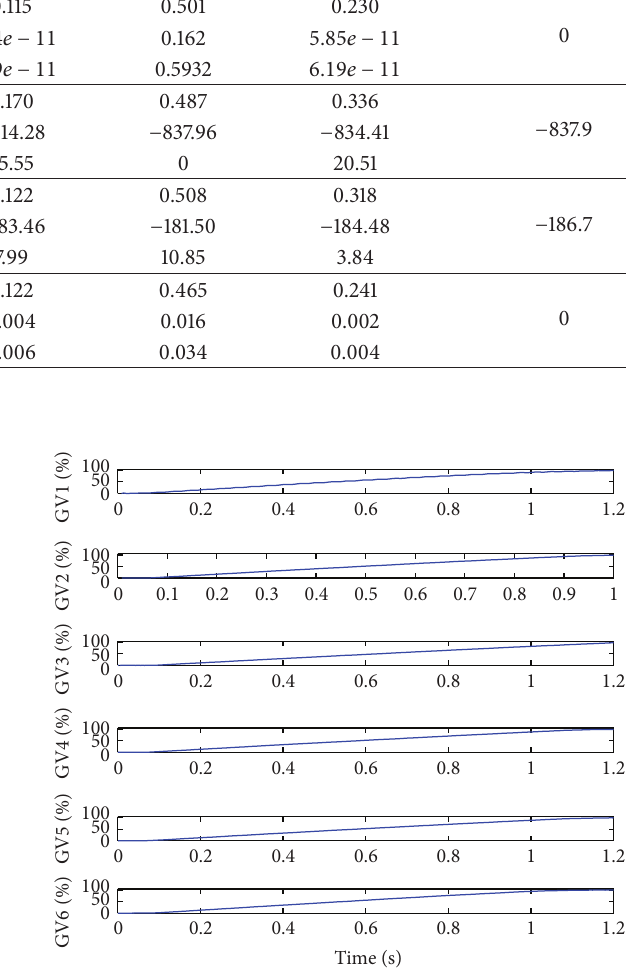
Figure 7: Servo and actuator fully open wave record of Xiaolongtan power